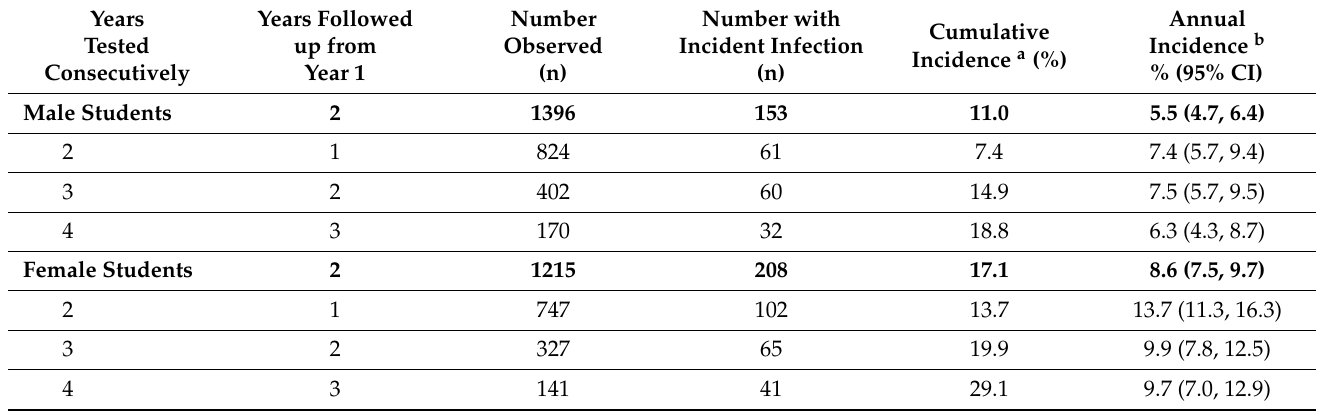
Table 5. Cumulative incidence among 1396 male and 1215 female students tested for chlamydia during 2, 3, and 4 consecutive school years (total = 2611).